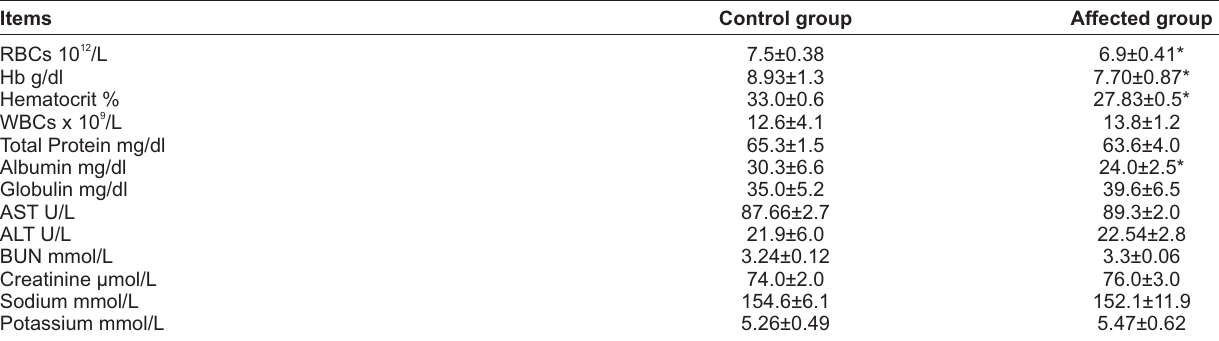
* Significant difference at p